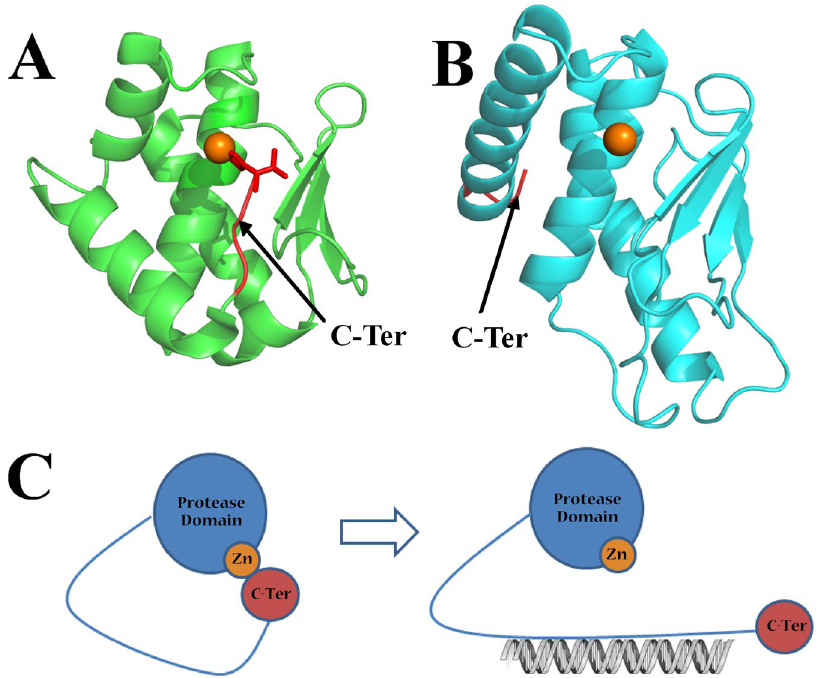
Figure 7. ( A ) Crystal structure of proabylysin (PDB: 4JIU). ( B ) Crystal structure of ScWss1 21-148 (PDB: 5XBN). The overall structures of the two proteins are shown in cartoon. The C-terminal tails of the two proteins are colored in red. ( C ) Speculated mechanism of ScWss1 activated by the DNA substrates. The protease domain, zinc ion, and the C-terminal domain of ScWss1 were schematically drawn as blue sphere, orange sphere, and red sphere, respectively. The flexible region which links the N-terminal and C-terminal of the protein is drawn as blue